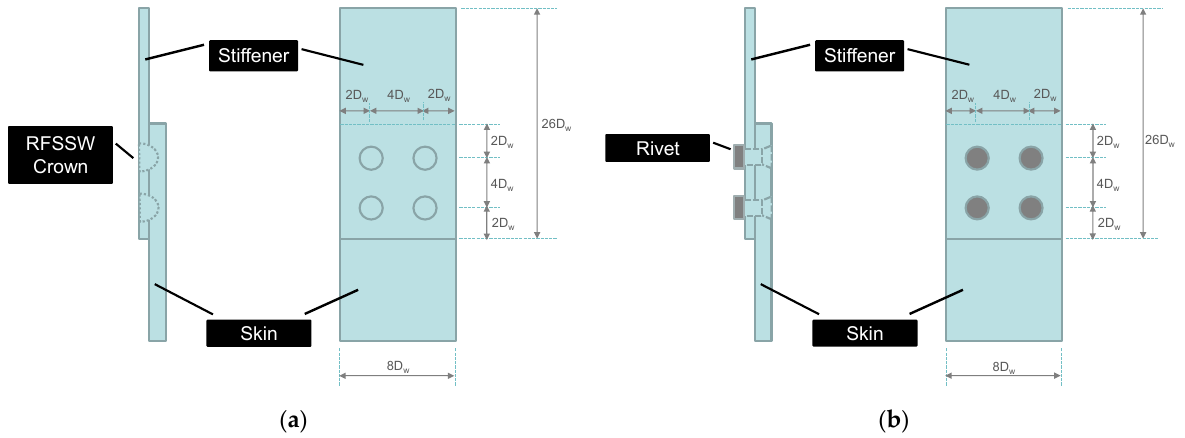
Figure 6. Four-spot coupon configurations in accordance with NASM-1312-21: ( a ) 4-refill-spot-weld coupon configuration and ( b ) 4-rivet-joint coupon configuration. D w is the refill spot weld diameter, which is 7